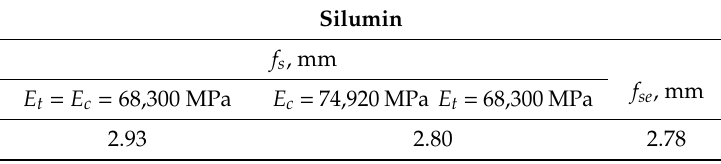
Table 2. The theoretical and experimental value of the maximum deflection of the beam from